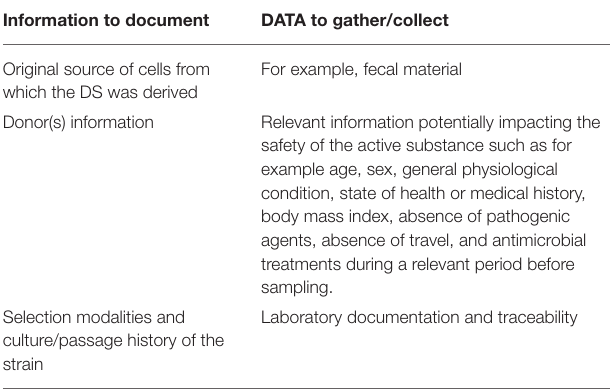
TABLE 1 | Essential information to document the origin of the